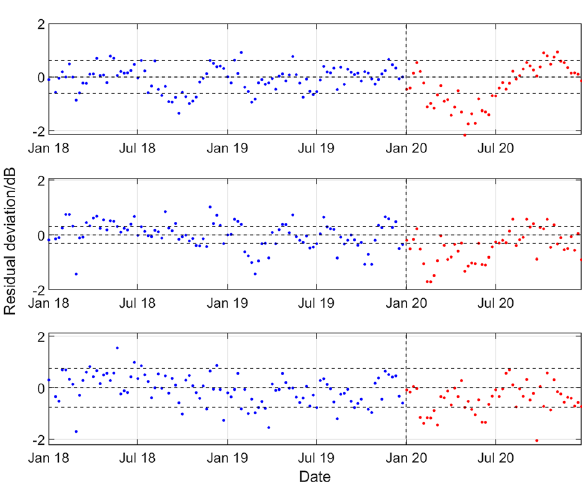
Figure 7. Results for the northern triplet hydrophone H11N1 data recorded at the CTBT Wake Island station, statistical level P 10 and (top to bottom) low, medium, and high frequency bands. For the period January 2018 to December 2019 and during 2020, deviations of the observed weekly SPSDL data from the predictable part of the signal defined by the long-term and medium-term seasonal components of the GP